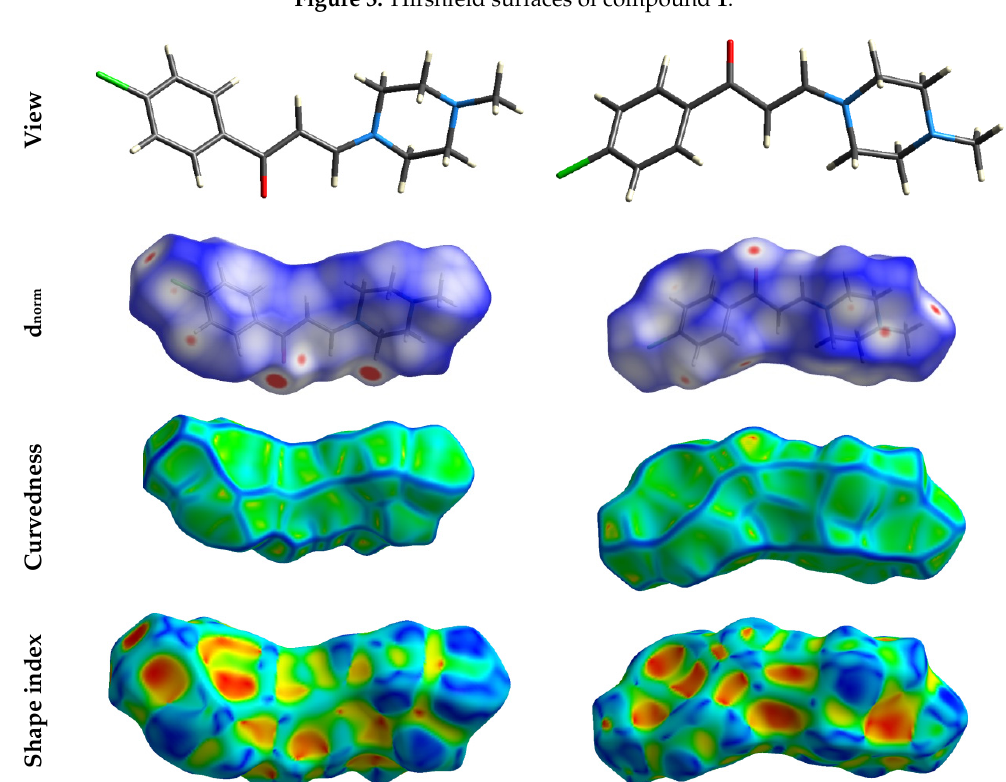
Figure 3. Hirshfeld surfaces of compound 1 .